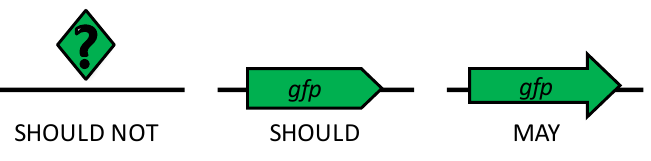
Figure 1: A biological design element such as a protein coding sequence (CDS) is best represented by the most specific RECOMMENDED glyph (middle), but can be represented by a less specific glyph such as Unspecified (left) or an approved alternative glyph